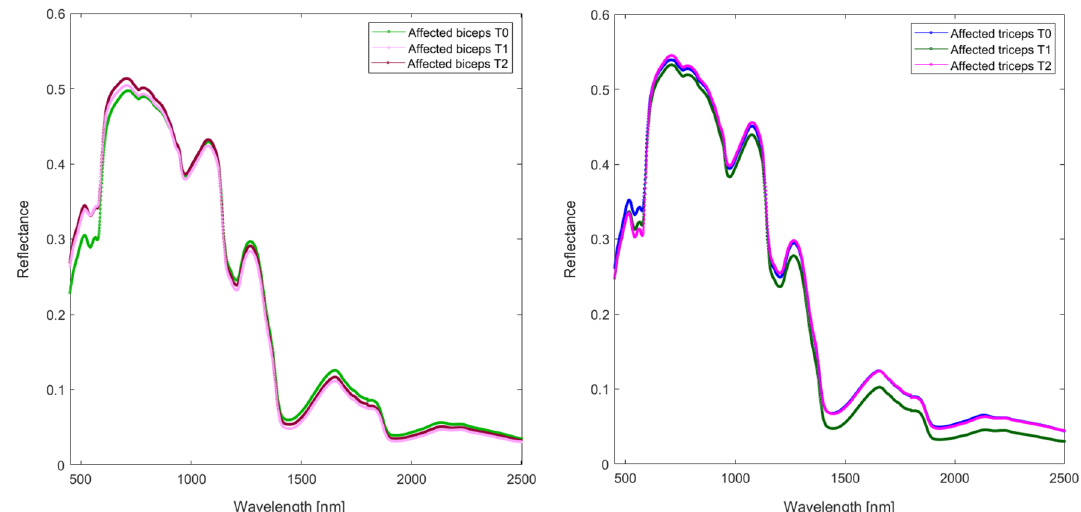
Figure 4. Average reflectance spectra of affected biceps and affected triceps at T0, T1, and T2.